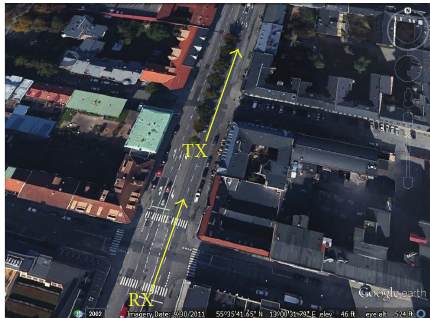
Figure 2: Aerial shot of the measurement route on an urban road in Malm¨o, Sweden (N 55 ∘ 35 󸀠 41 󸀠󸀠 , E 13 ∘ 0 󸀠 31 󸀠󸀠 ).